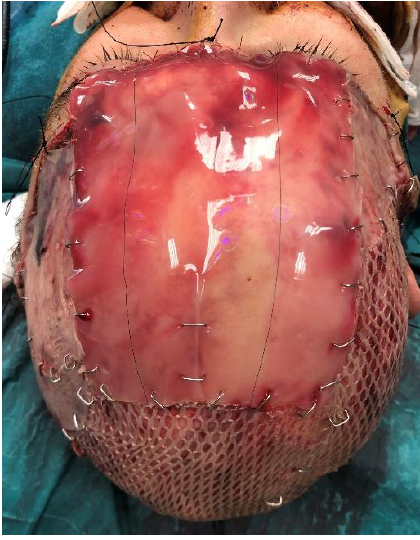
Figure 3. Positioning of the dermal substitute.